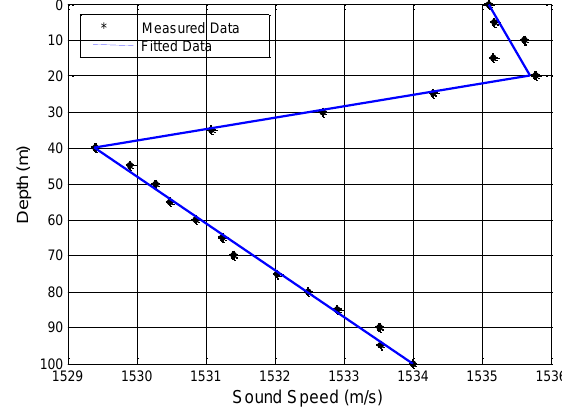
Figure 7. Sound speed variation with depths in a zone in the China